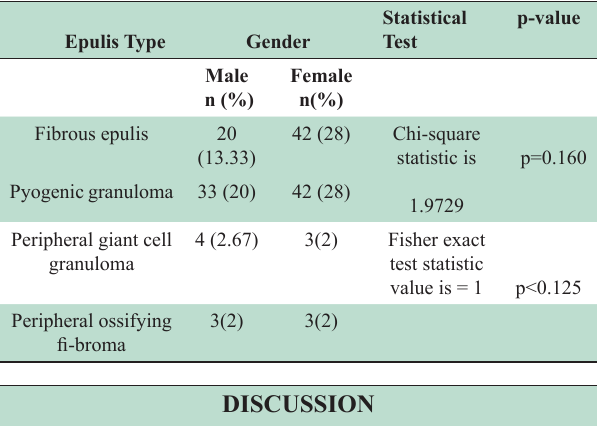
Table-IV: Distribution of histological diagnosis according to gender (n=